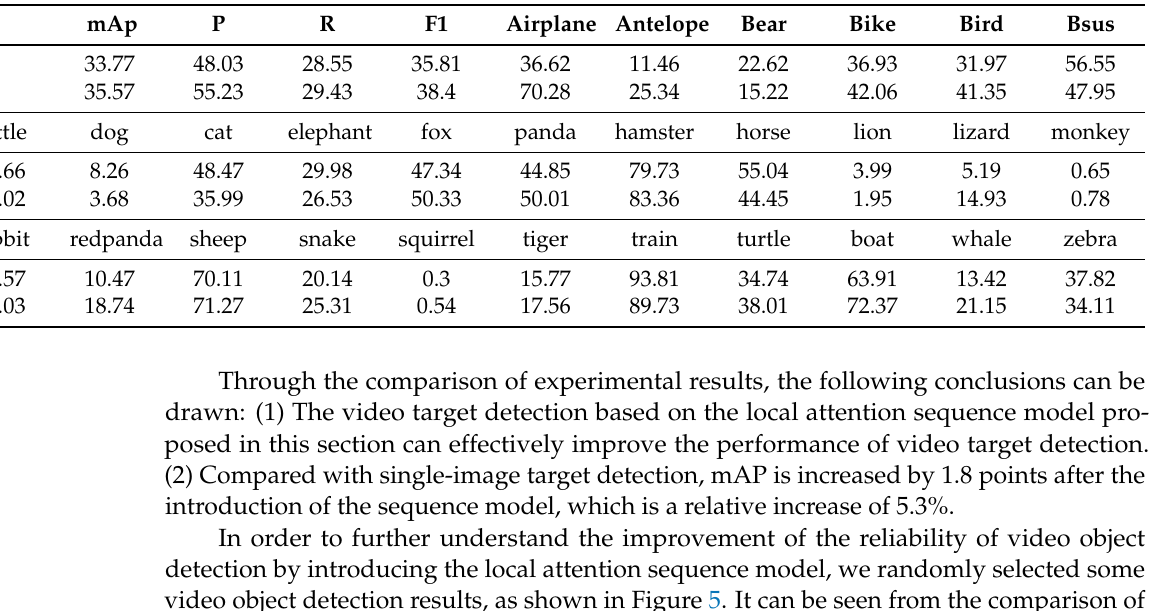
Table 1. Performance of our method on ImageNet